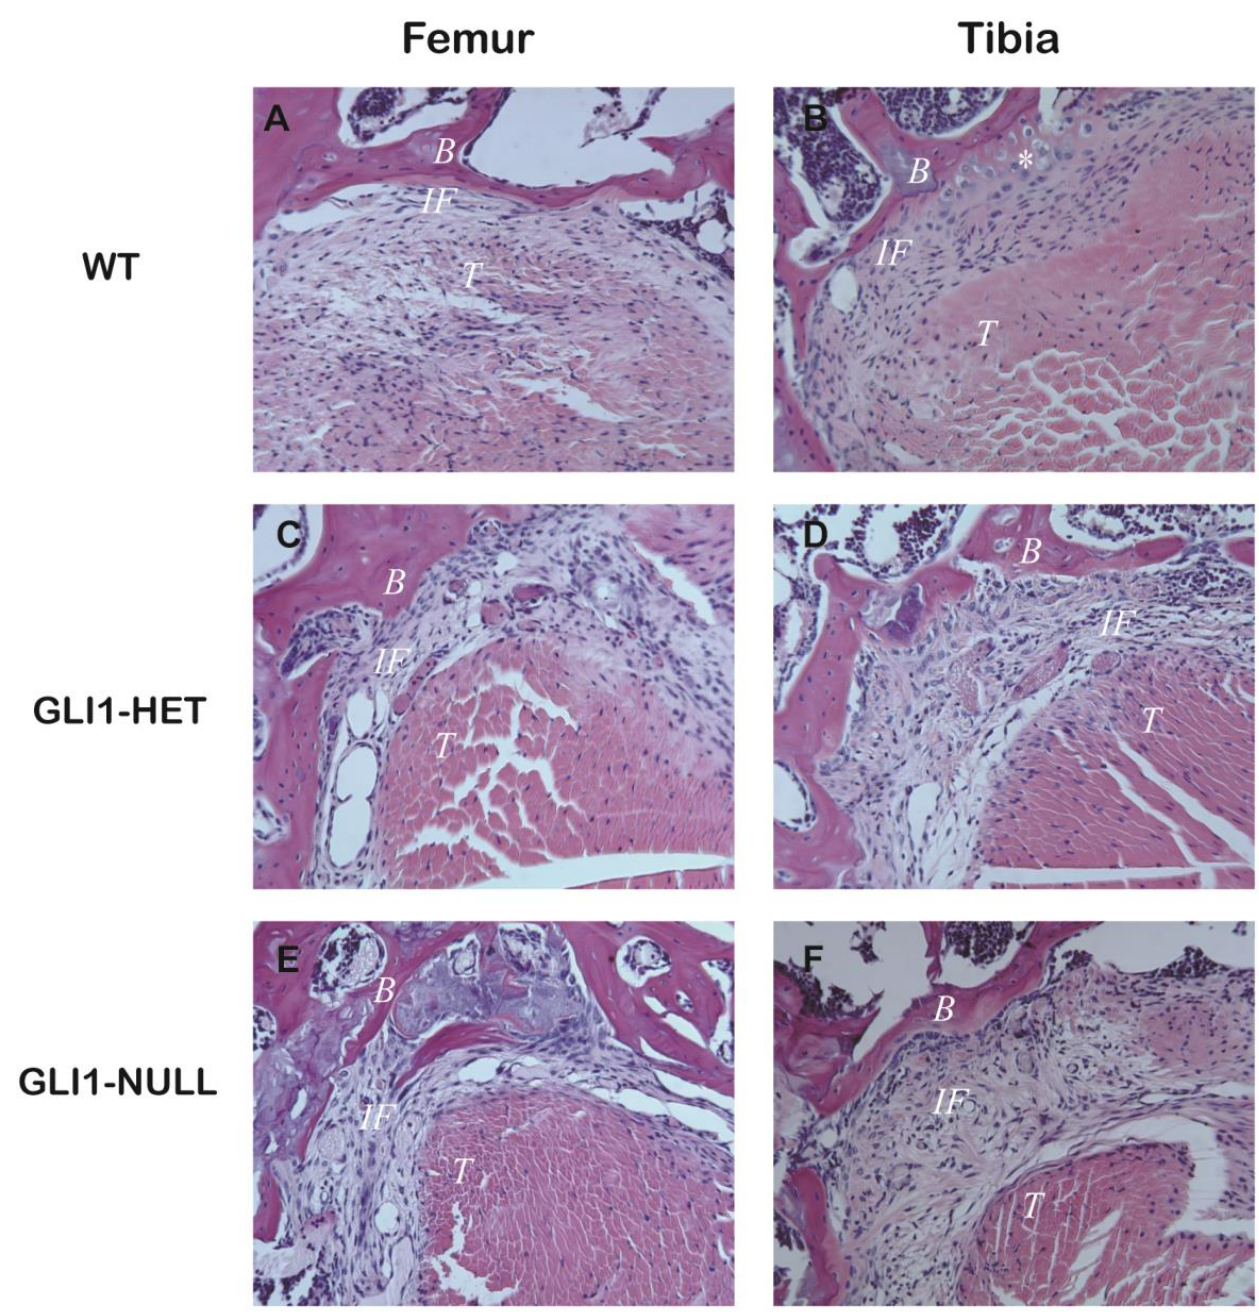
Figure 3. Hematoxylin and eosin staining of the tendon–bone interface of wild-type ( A , B ), GLI1-HET ( C , D ), and GLI1-NULL ( E , F ) mice at 4 weeks after ACLR (20 × ). Obvious fibrovascular tissue and wider and more distinct interface in the tendon–bone connection at both femoral and tibial sides could be observed in the GLI1-NULL group. (B: Bone tissue, IF: Interface, T: Tendon graft). Safranin-O staining showed some fibrocartilage-like cells at the tibial tunnel interface in the WT group and GLI1-HET group, while rare cartilage-like cells could be seen in the